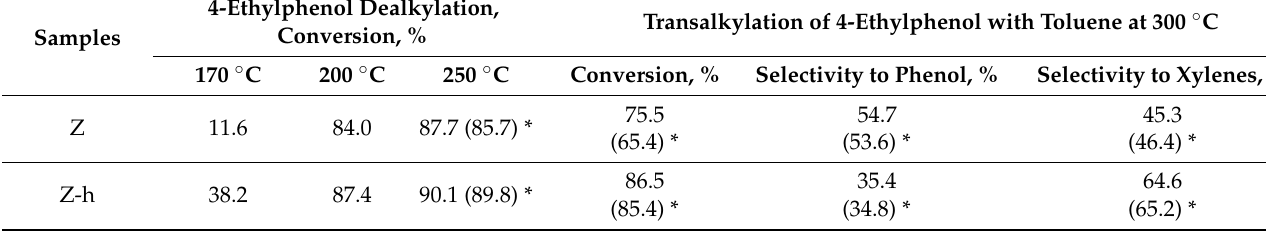
Table 3. Catalytic activity of the initial and hierarchical ZSM-5 zeolite in dealkylation of 4-ethylphenol and transalkylation of 4-ethylphenol with toluene.